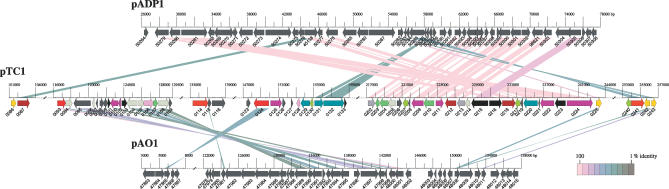
Comparative Linear Display Representing the Sequence Homologies between the A. aurescens pTC1 Plasmid, the Pseudomonas sp. pADP-1 Plasmid, and the A. nicotinivorans pAO1 PlasmidOnly selected regions for each of the three plasmids are shown. The percent of protein identity is indicated by the color of the connecting lines (legend on the bottom left side of the figure). For clarity, the locus tags (AAur_pTC1 for the pTC1 plasmid, AAK for the pADP-1 plasmid, and CAD for the pAO1 plasmid) were removed from the ORF numbers.